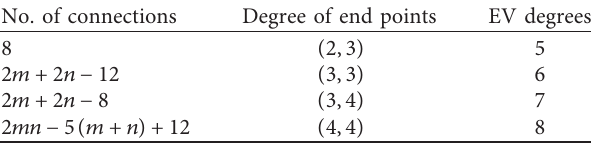
Table 4: Points partitioning of ( MN